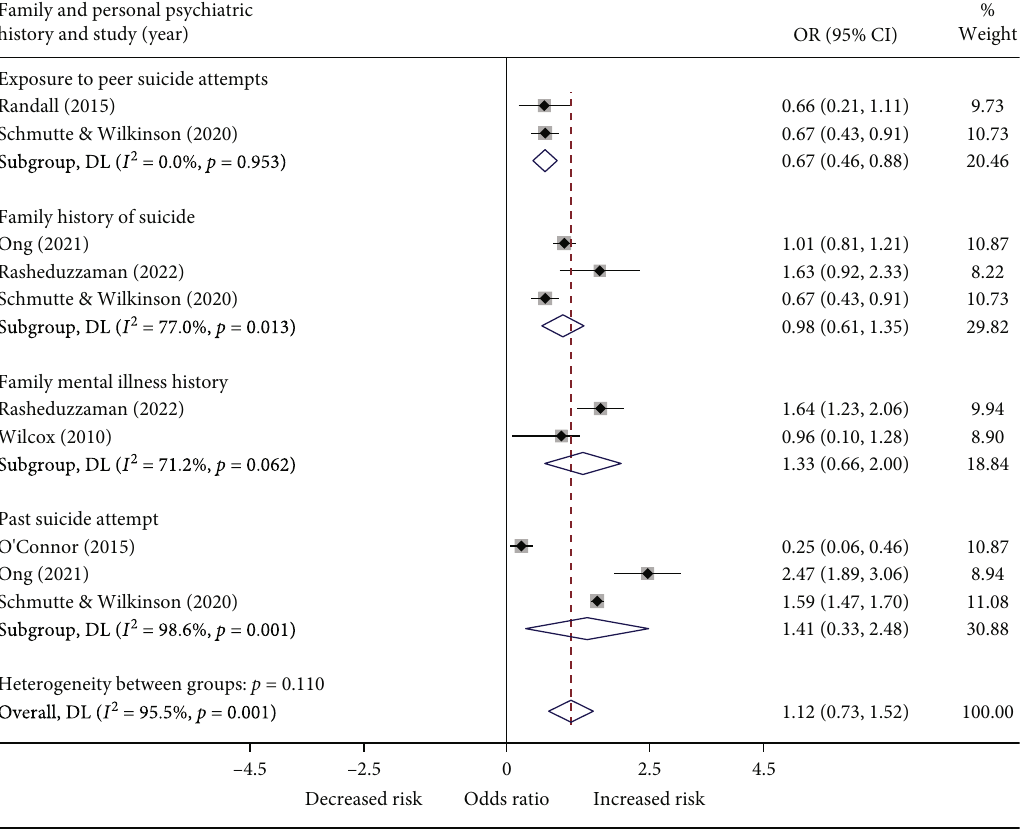
Figure 5: Family and Personal psychiatric history as risk factors for suicide. Studies are identi fi ed from the fi rst author and publication year. The size of grey boxes represents the weight attributed to each study. Weights are from the random e ff ects model. The diamonds denote the pooled summary e ff ect size and CI ’ s (95% con fi dence interval). OR = Odds ratio. Risk factors in the domain family and personal psychiatric history, that are most strongly associated with suicide are family history of suicide and past suicide